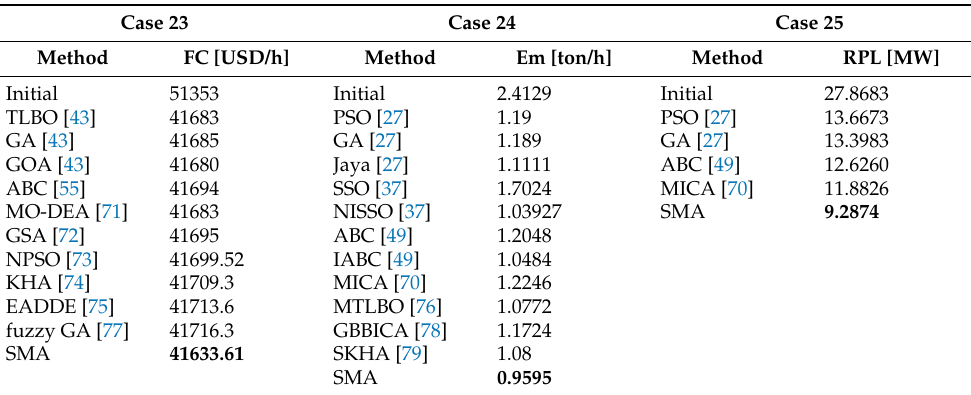
Table 9. Comparison of the results obtained by SMA with other methods from Cases 23-25 on the IEEE 57-bus system.